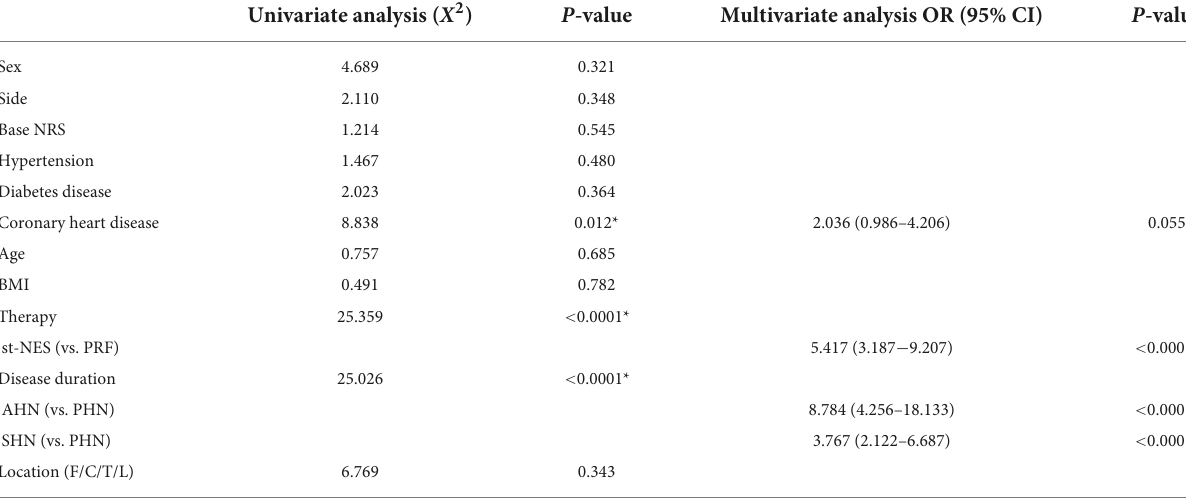
TABLE 2 Risk factors for efficacy after minimally invasive neuromodulation ( n =